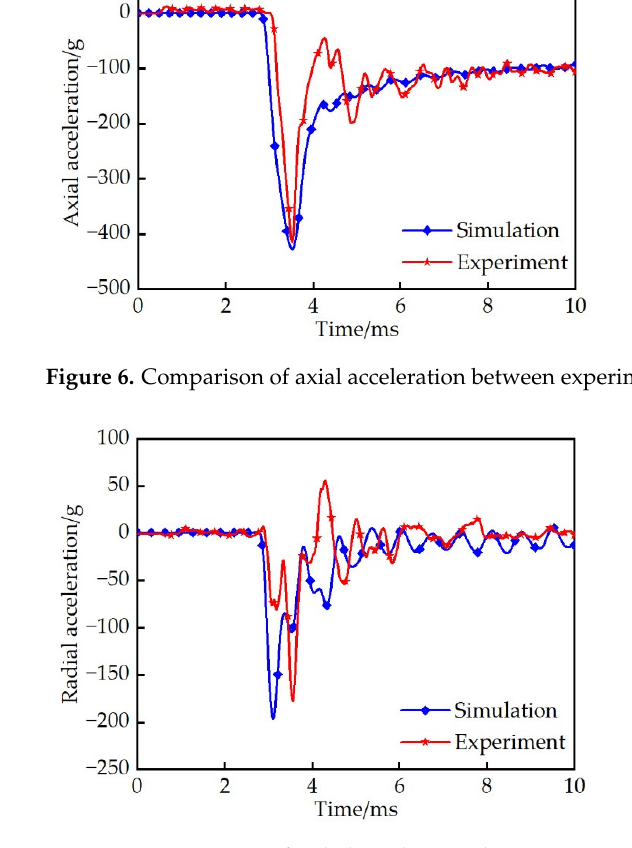
Figure 9. Peak and peak pulse width of mesh with different size. The interference of wall effect on the calculation results should be minimized during the numerical calculation. Therefore, the dimensions of calculation domain is 10 m × 6.4 m × 12 m, the bottom is set as fixed boundary condition, and the surrounding wall is set as non-reflective boundary condition to reduce the influence of the wall effect on the re- sults, as shown in Figure 10. The calculation situations are shown in Table 9.